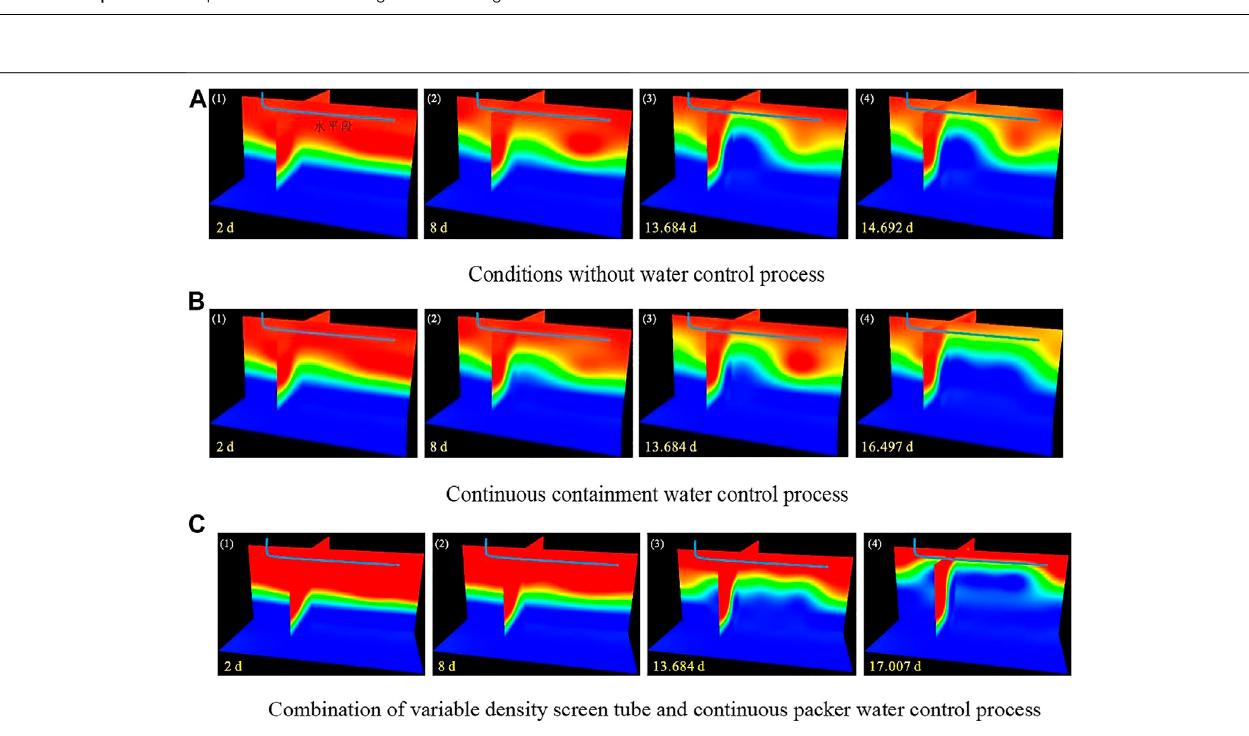
FIGURE 5 | Evolution of the gas – water saturation fi eld under different water control measures. (A) Conditions without water control process. (B) Continuous containment water control process. (C) Combination of variable density screen tube and continuous packer water control process.